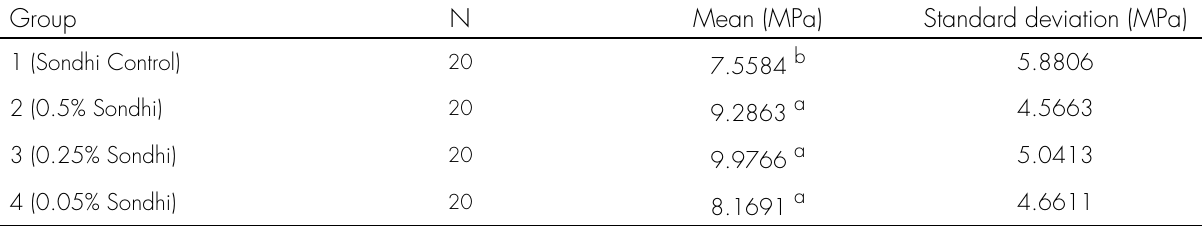
a,b Similar letters indicate no statistically significant differences between groups ( p > 0.05).